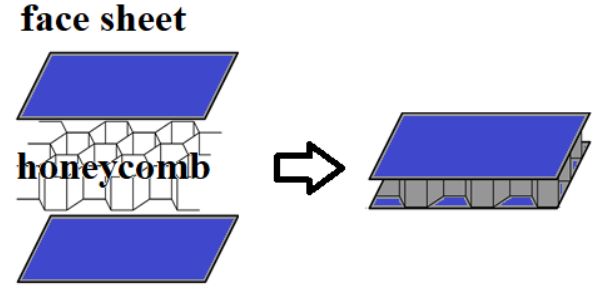
Figure 3. Honeycomb sandwich panel. Table 3. Sandwich structure with honeycomb core.